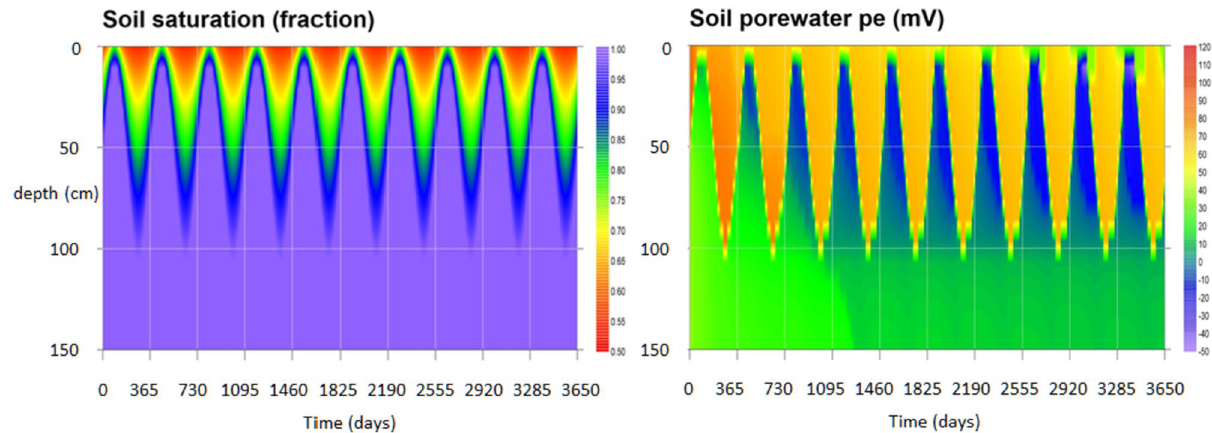
Fig. 1 Soil pe during a period of 3650 days (10 year cycles). Time (in days) on the x-axis, the soil depth (in cm) on the y-axis. The redox potential pe (mV) varied between -50 mV and + 120 mV. Val-